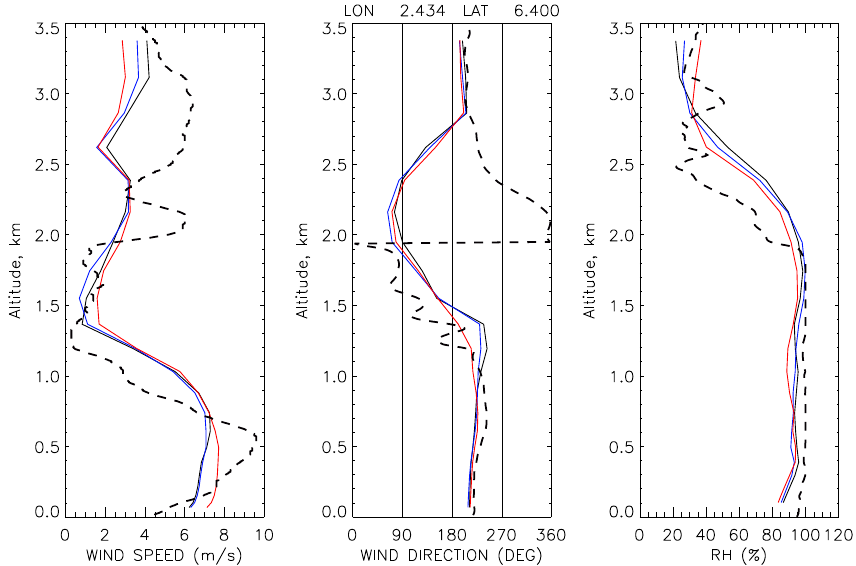
Fig. 8. Wind speed, wind direction and relative humidity from dropsonde launched at 10:40UTC (black dashed) and from the 8km-anthro BOLAM simulation at 10:00UTC (black), 12:00UTC (blue) and 14:00UTC (red) on 19 August over Cotonou.